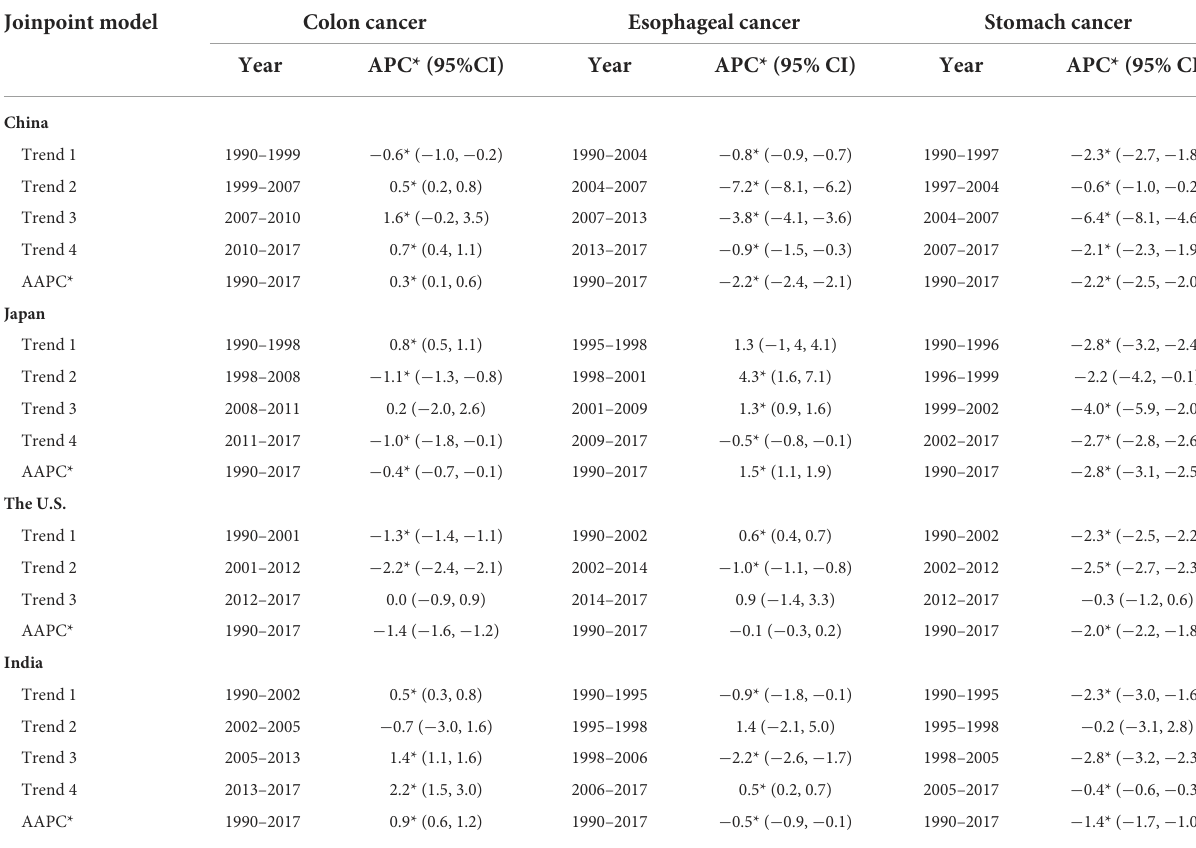
TABLE 1 Trends in age-standardized death rates of colon, esophageal and stomach cancer in China, Japan, the U.S., and India,